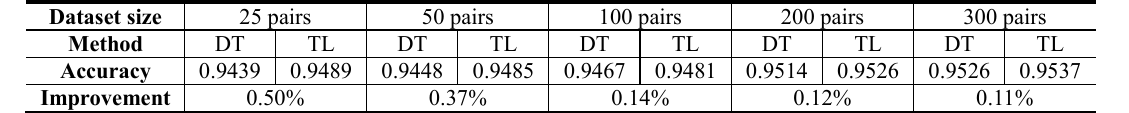
Table 5 is the test accuracy on different size of training samples on München dataset based on GC-Net. DT means directly training on the target dataset with random initial weights, while TL means transfer learning with pre-trained parameters on the Driving dataset. The accuracy of TL on 25 training samples is 96.5%, compared to 78.3% of DT. As the size of training set increases, the gain of TL slows down up to 0.61% when 250 pairs are used for training.